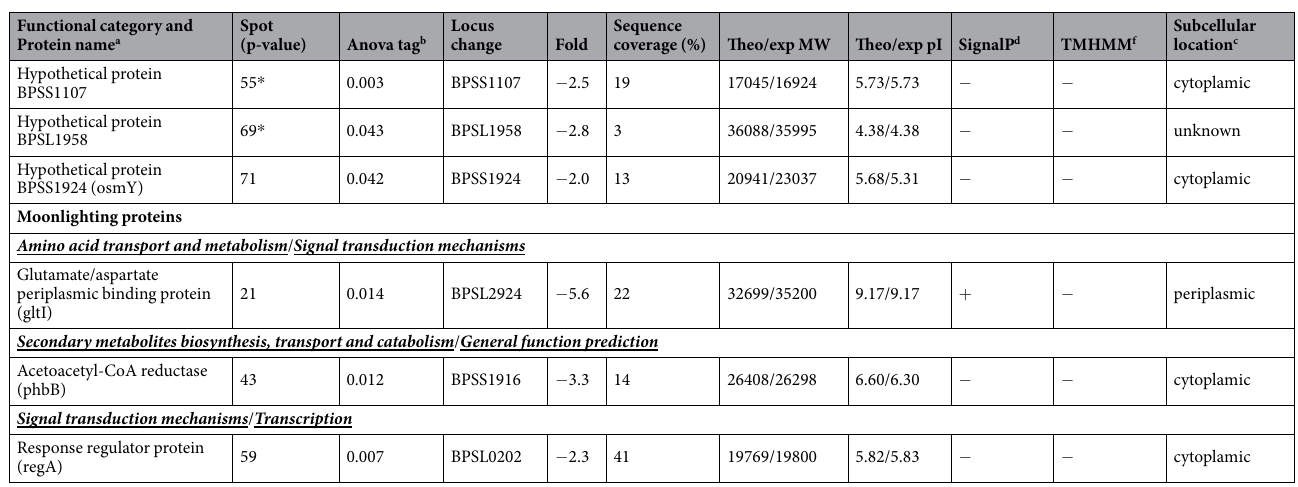
Table 3. Identification of Burkholderia pseudomallei soil isolate, Bp MARAN , down-regulated proteins in National Centre for Biotechnology (NCBI) non-redundant sequence using Mascot search engine data from MALDI- TOF mass spectrometry. * Missing proteins in Bp MARAN . a Functional category based on Clusters of Orthologous Groups (COG) of protein. b Locus tag obtained from Burkholderia Database. c Subcellular location predicted using the PSORT analysis. d Presence of signal peptide predicted by SignalP server v. 3.0. e Number of predicted transmembrane helices in protein using TMHMM server v.